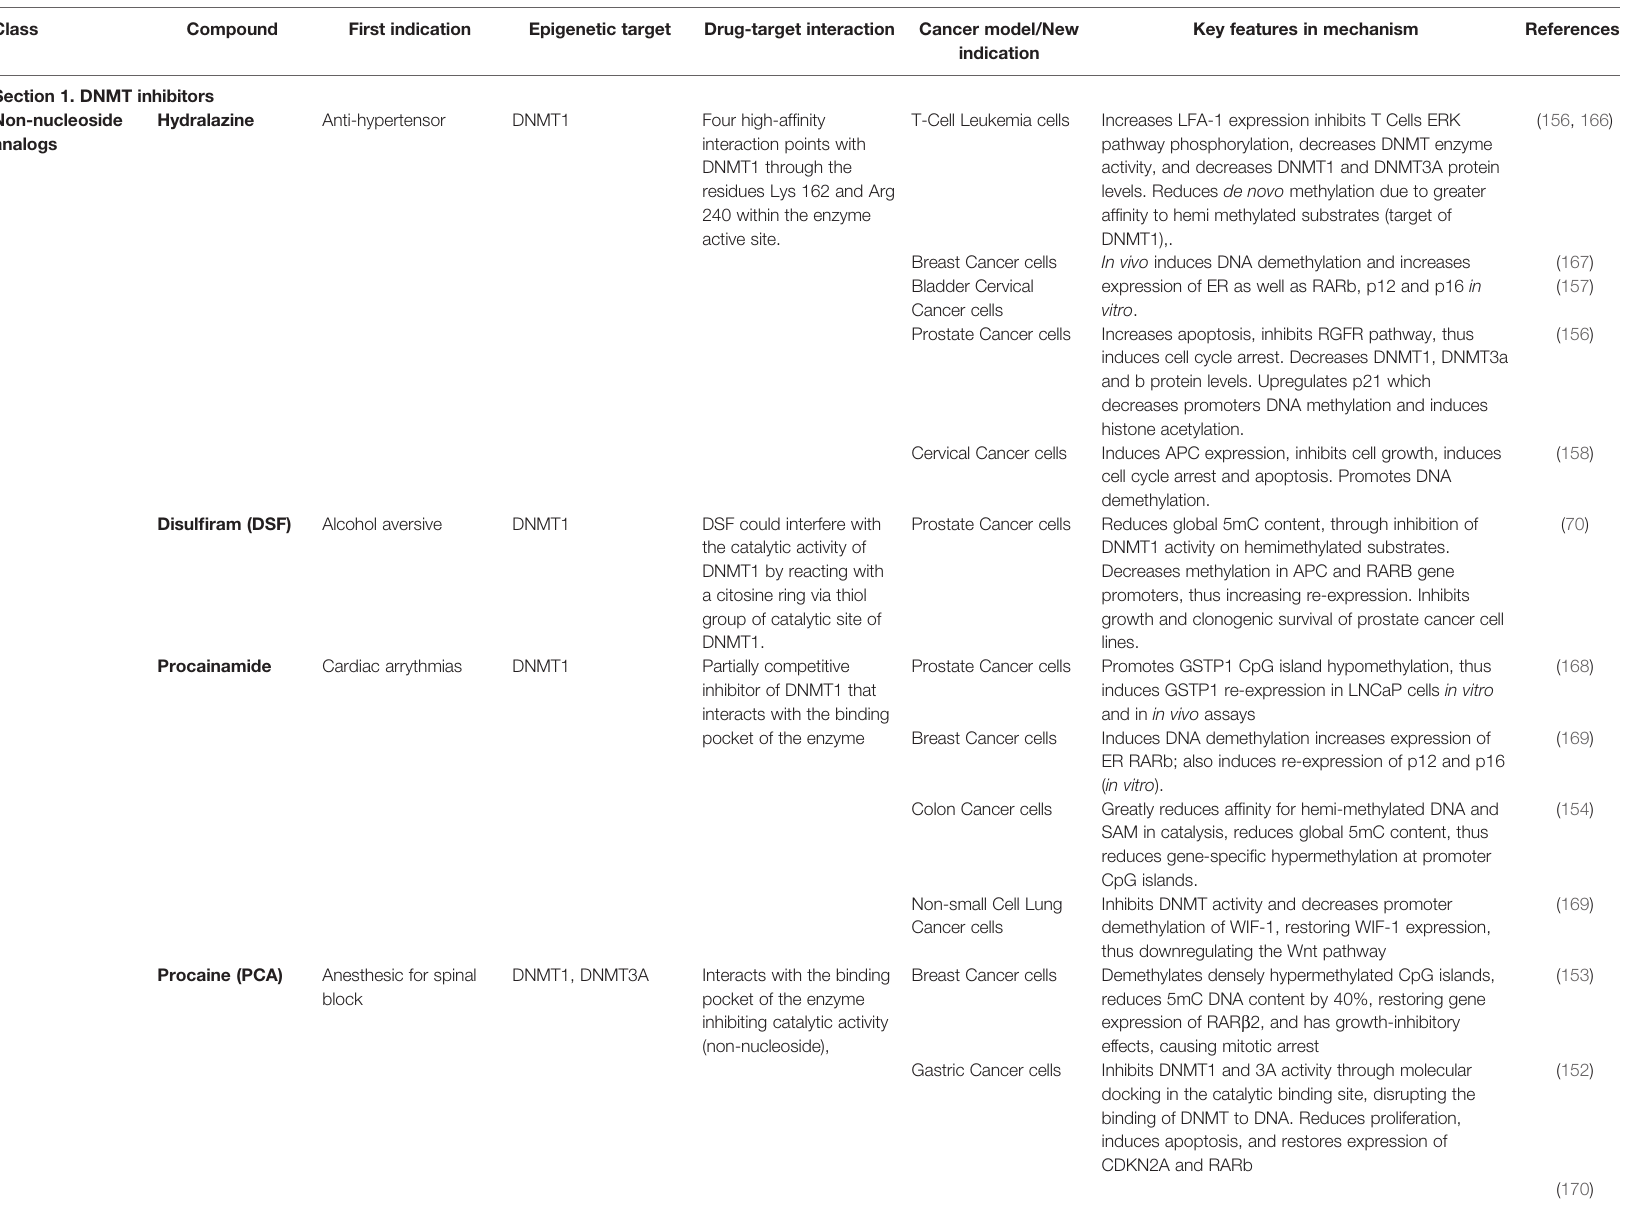
TABLE 4 | Current DNMTi and DNMT-HDAC dual inhibitors repurposed drugs with applications in cancer therapy [*modi fi ed from Moreira-Silva et al.